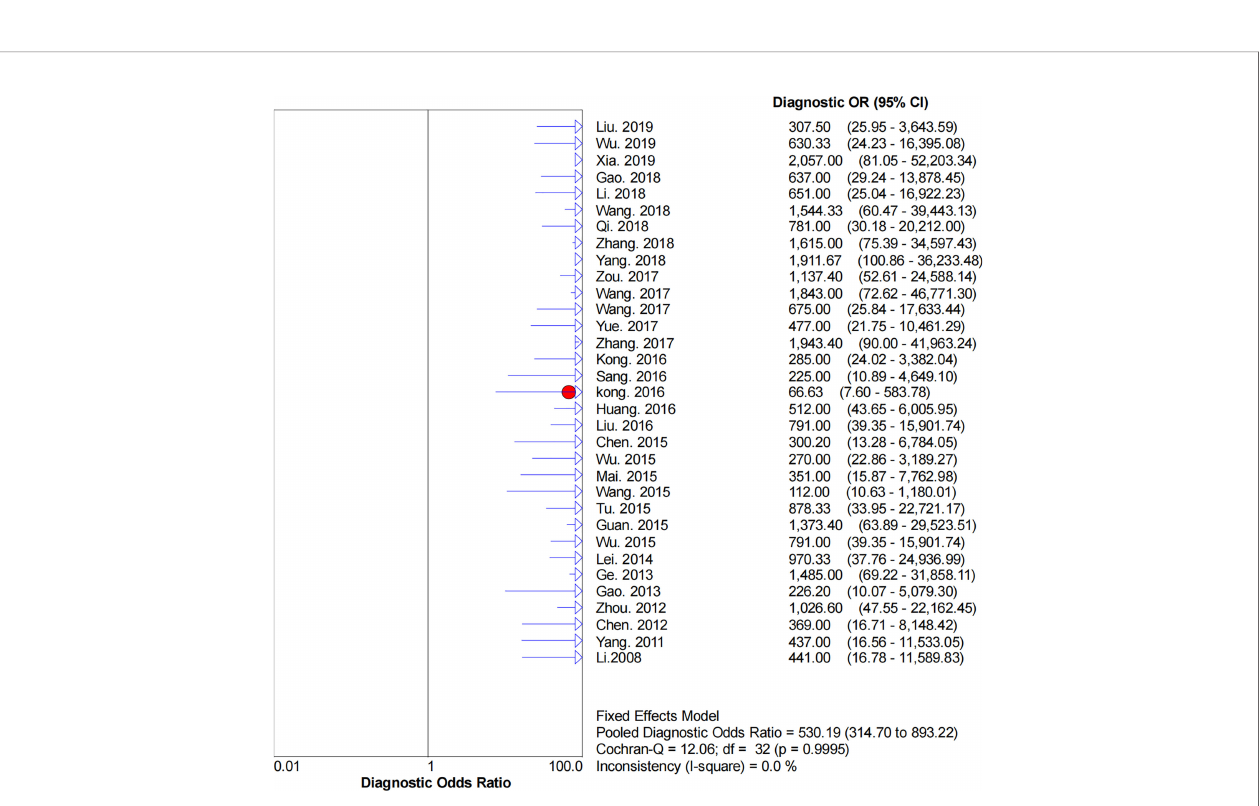
FIGURE 6 | Forest plot of pooled DOR of the diagnosis value of CNSs in SLNB of breast cancer. 95% CI, 95% con fi dence interval. DOR, diagnostic odds